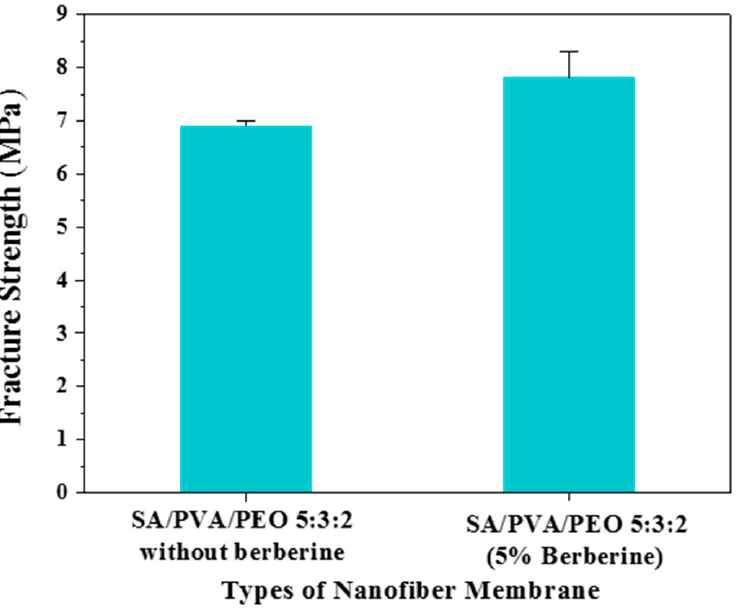
Figure 8. Fracture strength comparison between SA/PVA/PEO MFMs 5:3:2 without berberine and SA/PVA/PEO containing 5 wt.% berberine.